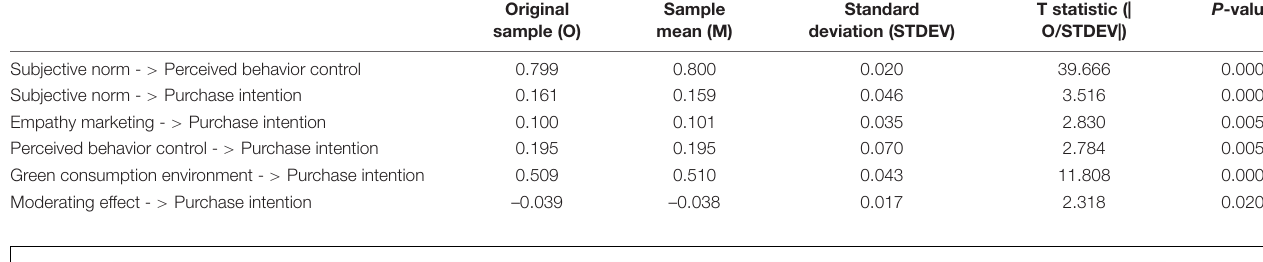
TABLE 4 | Path coefficients of the model.